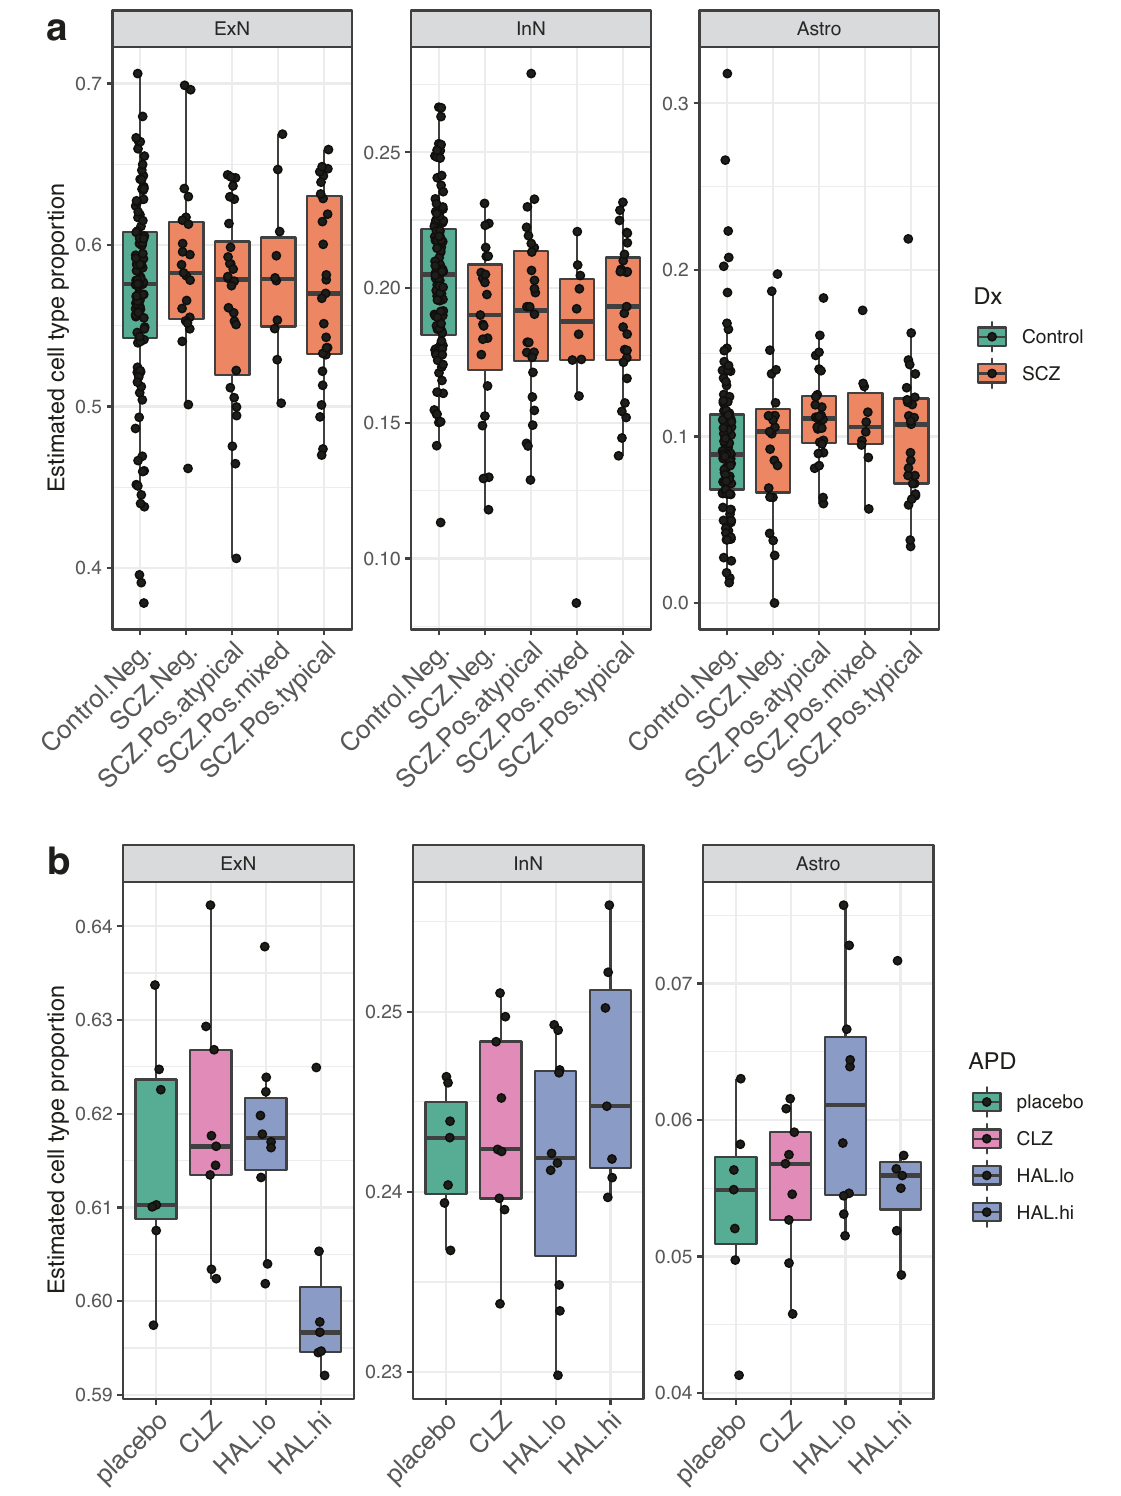
Fig. 3 Estimated cell-type proportions for human and macaque DLPFC samples. a Cell-type proportions of excitatory neurons (ExN), inhibitory neurons (InN), and astrocytes (Astro) in bulk DLPFC tissue of SCZ cases with different toxicological pro fi les (groups as in Fig. 1a) estimated via corresponding single-nucleus RNA-seq pro fi les. Kruskal – Wallis test (KWt) on all groups: p ExN = 0.908; p InN = 0.0318; p Astro = 0.0689; KWt within SCZ subgroups only: p ExN = 0.798; p InN = 0.875; p Astro = 0.565. Mann – Whitney U -test (MWU) between SCZ and controls was signi fi cant for InN ( p = 0.00159) and Astro ( p = 0.0176). Only InN remained signi fi cant after FDR correction. b Estimated proportions of ExN, InN, and Astro in bulk DLPFC of monkeys treated with clozapine (CLZ), haloperidol (low dose: HAL.lo; high dose: HAL.hi), or placebo. KWt: p ExN = 0.0433; p InN = 0.547; p Astro = 0.336. MWU between APDs and placebo was signi fi cant only for HAL.hi in ExN ( p = 0.0379). For detailed test statistics, see Supplementary Table S2. For the other cell types, see Supplementary Fig.